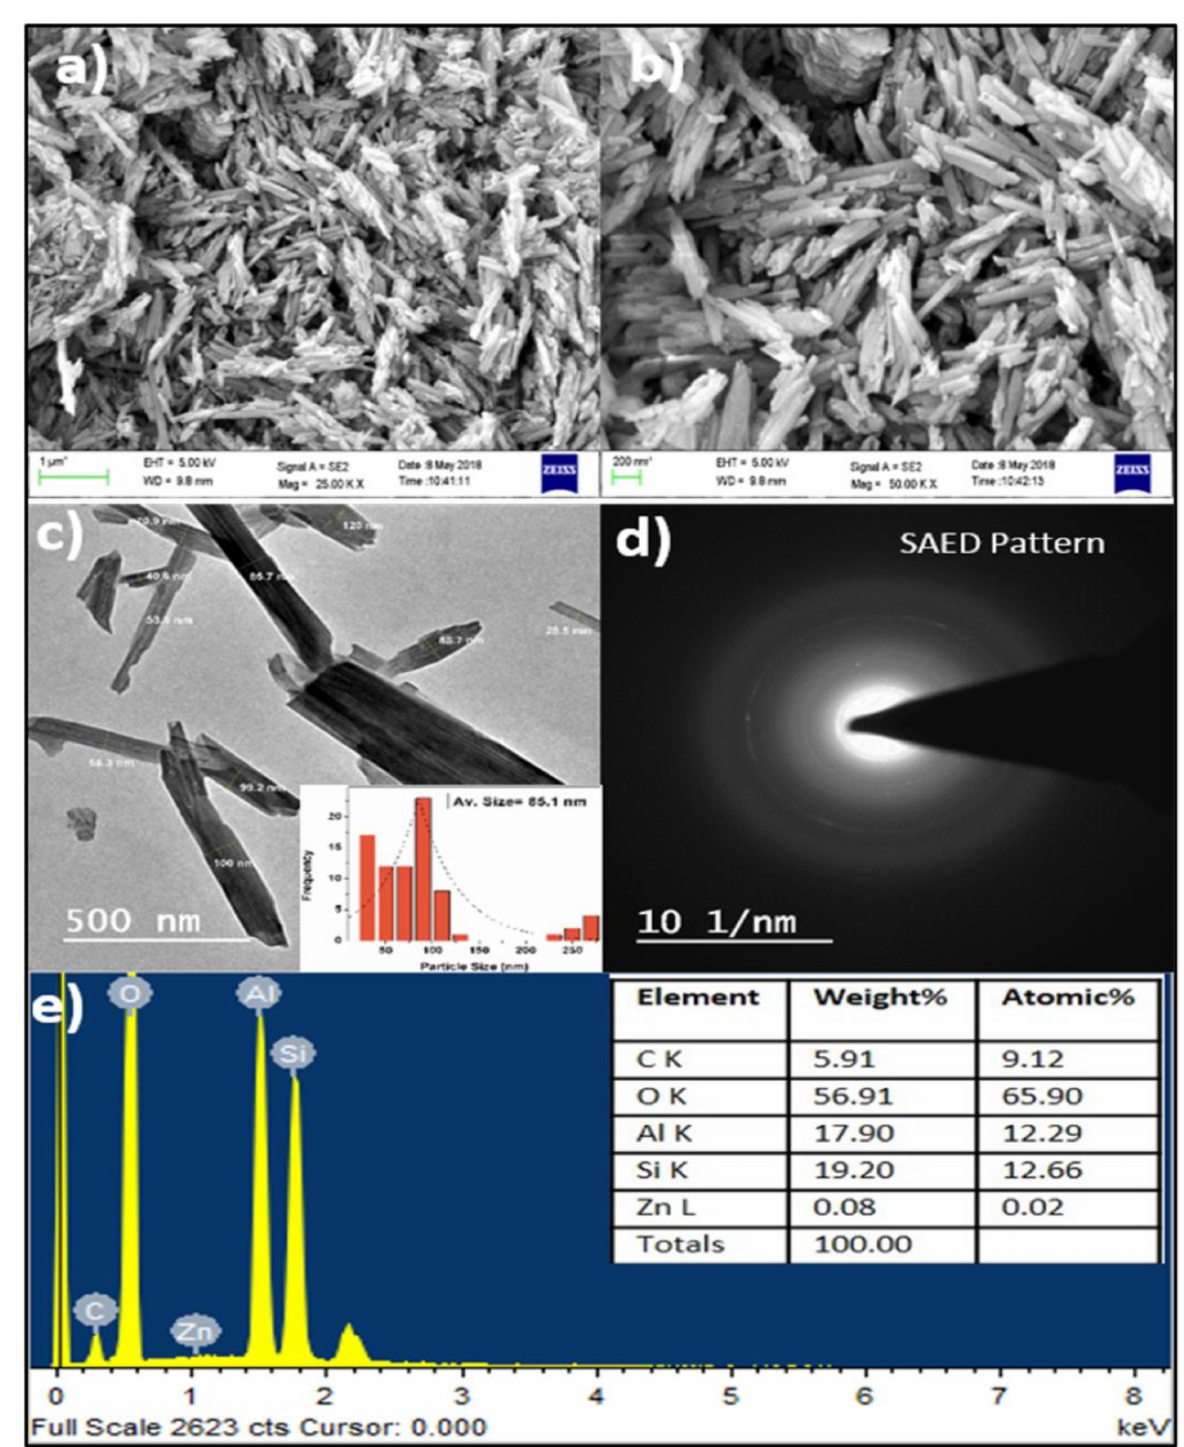
Figure 8. ( a , b ) FE-SEM micrographs; ( c ) HR-TEM images; ( d ) SAED pattern; ( e ) EDS spectra and elemental table of